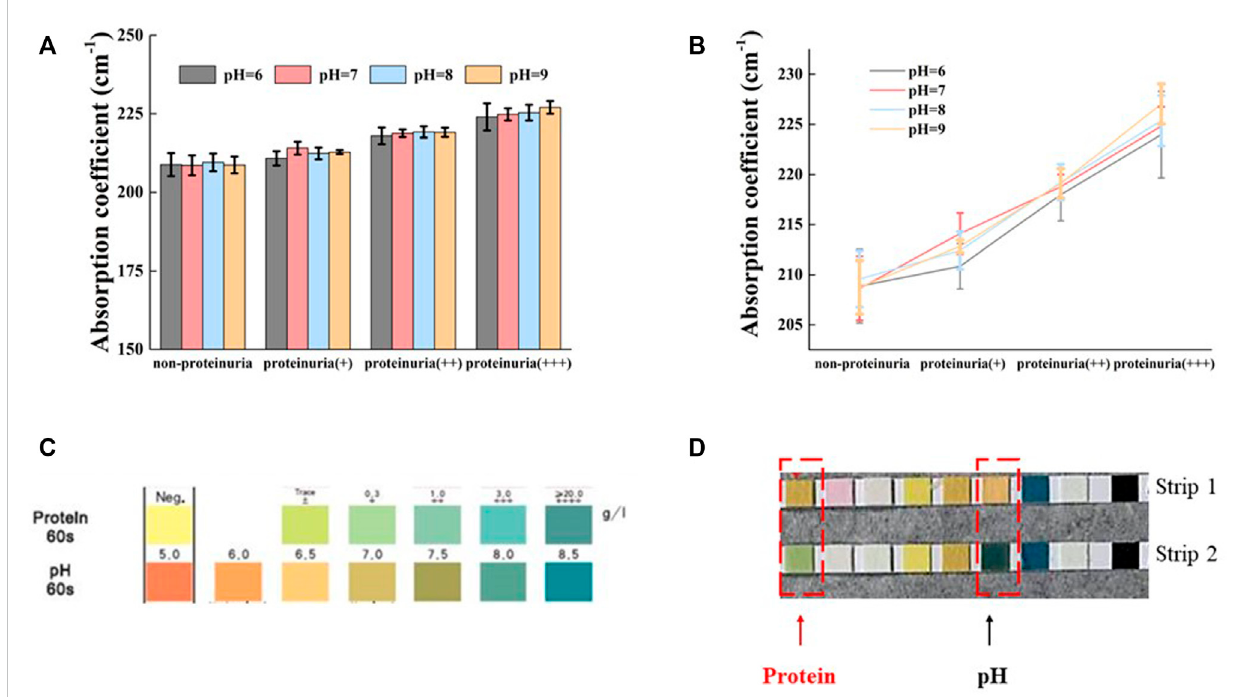
Effect ofpH ontheabsorptionofTHz indifferenturine (A) Variation ofurineabsorptioncoef fi cient with pHfor four differentproteinconcentrations at1.0 THz (B) Absorptioncoef fi cientsandproteinconcentrationsofurinewithdifferentproteinconcentrationsatthesamepH (C) Colorimetricmapping ofurineanalysisteststrips (D) Non-proteinuria(strip1)appearsfalsepositiveafterraisingpH(strip2).Alldataareshownasthemean±standarddeviation.